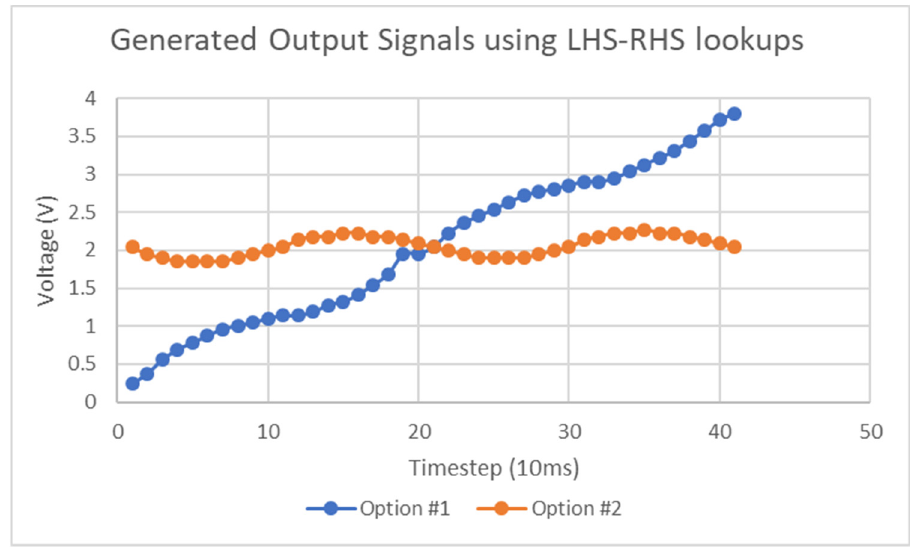
Figure 19. Possible stimulus curves applied to tag.